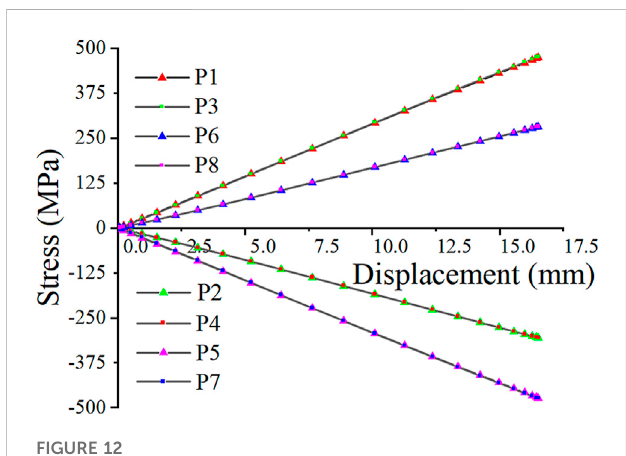
FIGURE 12 Stress-displacement curves of points on the hoop reinforcement